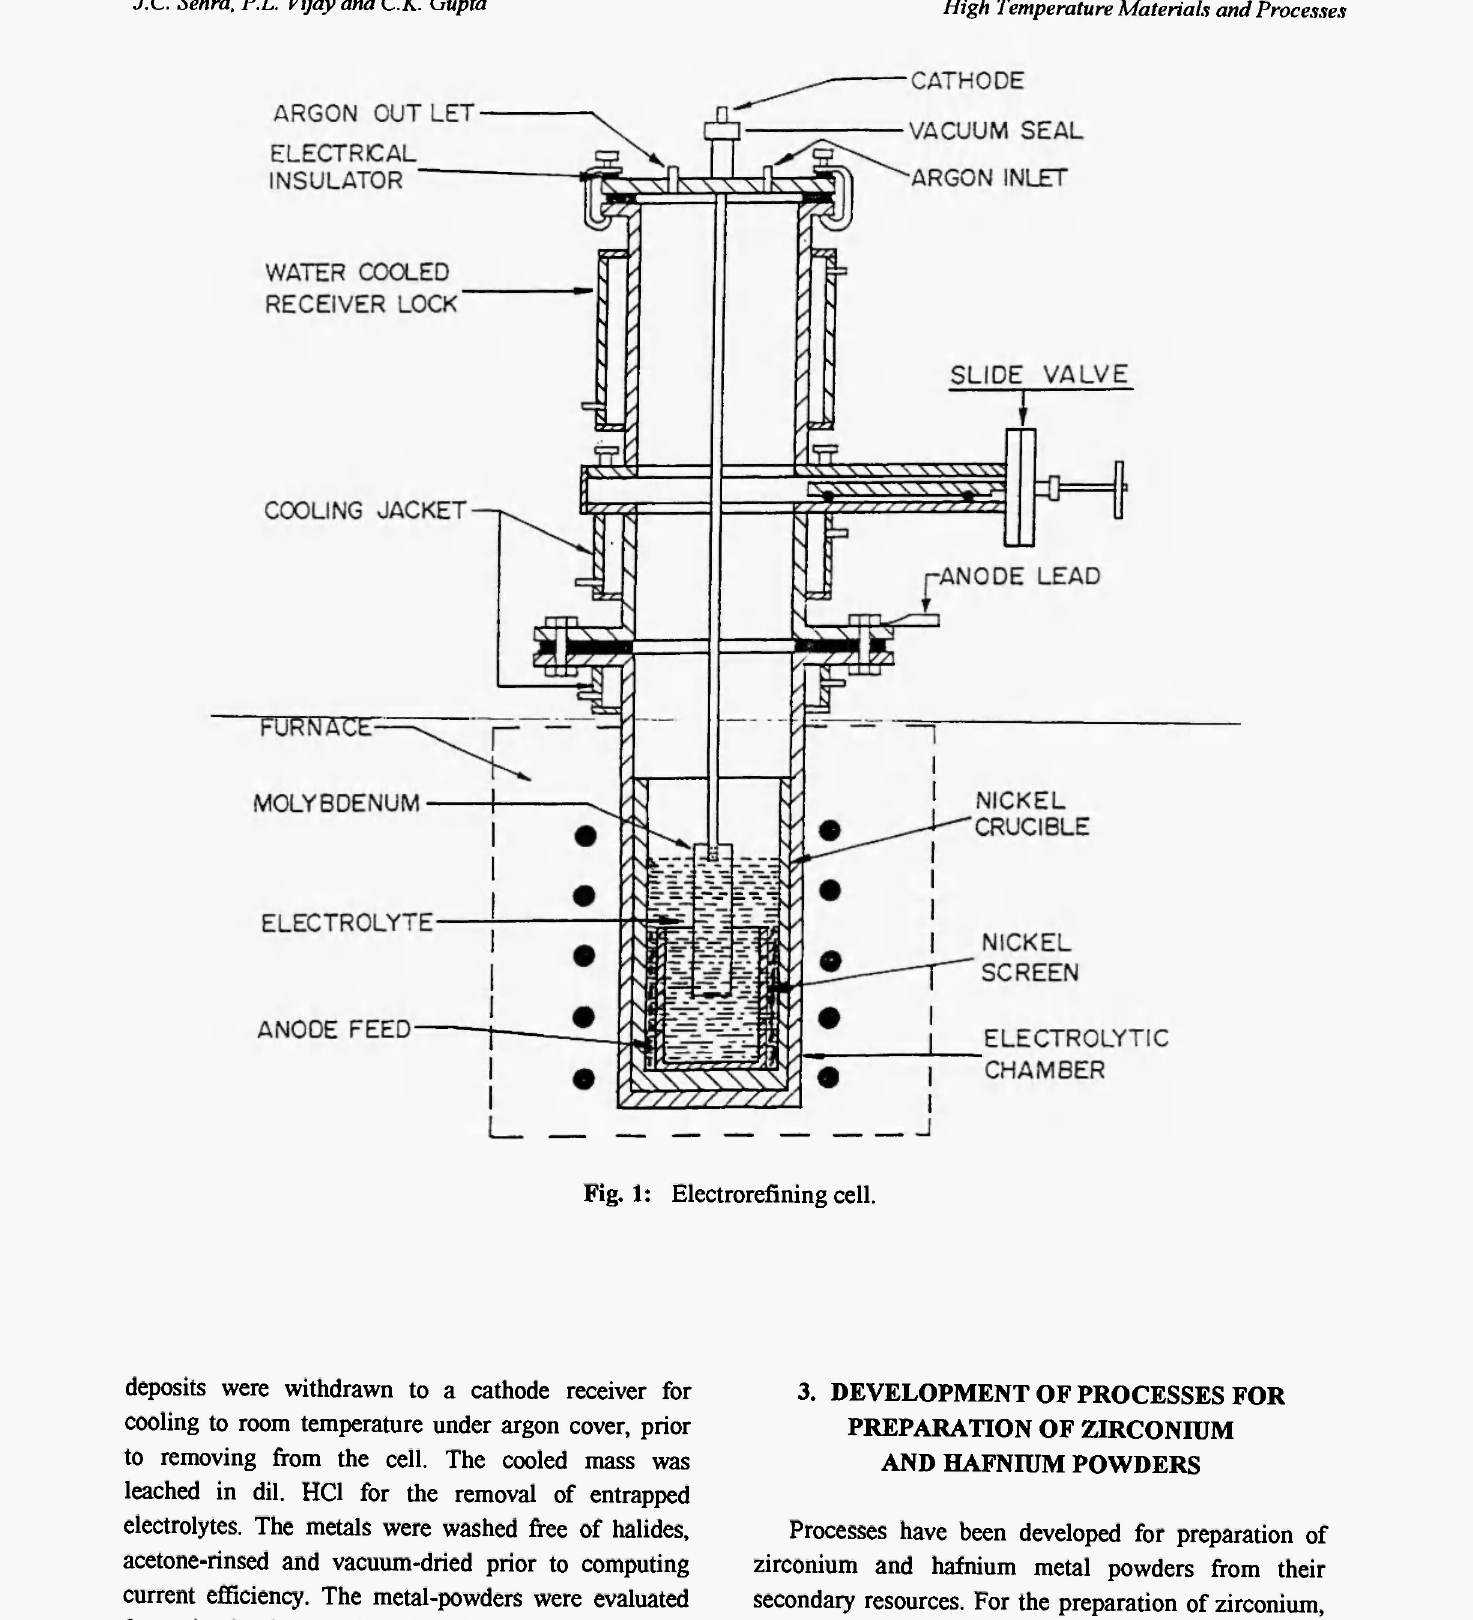
Fig. 1: Electrorefining